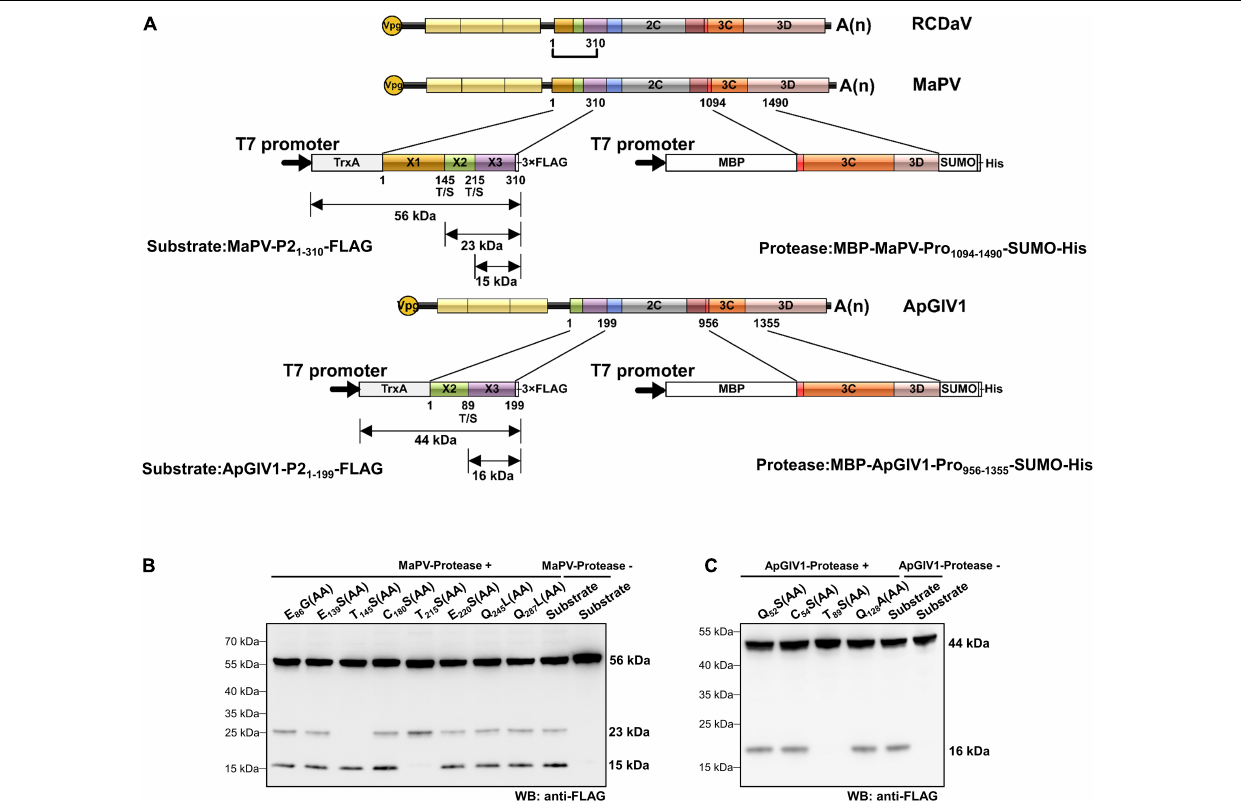
FIGURE 10 | Analyses of cleavage sites in the N-terminus of P2 regions of MaPV and ApGlV1 using in vitro trans -cleavage assays. (A) Schematic representation of the expressed substrates and the expressed proteases. MaPV-P2 1 − 310 and ApGlV1 1 − 199 were used as the substrates, and MBP-MaPV-Pro 1094 − 1490 -SUMO-His and MBP-ApGlV1-Pro 956 − 1355 -SUMO-His were used as the proteases. The calculated molecular mass of individual cleaved products is indicated. The predicted cleavage sites are shown as described in Figure 9 . (B) In vitro trans -cleavage analysis of the N-terminus of P2 regions of MaPV and their mutants. The indicated amino acids in the mutants were mutated to AA. (C) In vitro trans -cleavage analysis of the N-terminus of P2 regions of ApGlV1 and their mutants. The indicated amino acids in the mutants were mutated to